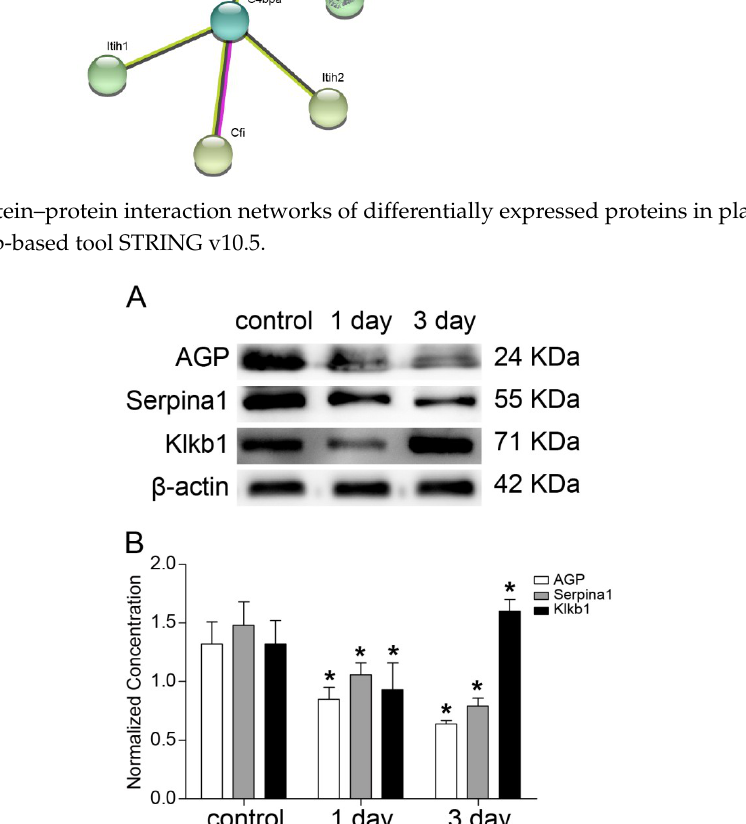
Figure 9. Western blot validation of the three differentially expressed proteins identified by